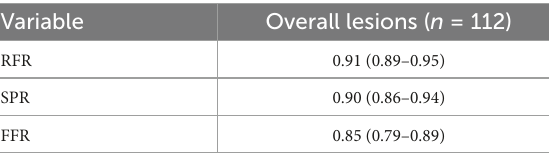
TABLE 2 Values of RFR, SPR, and